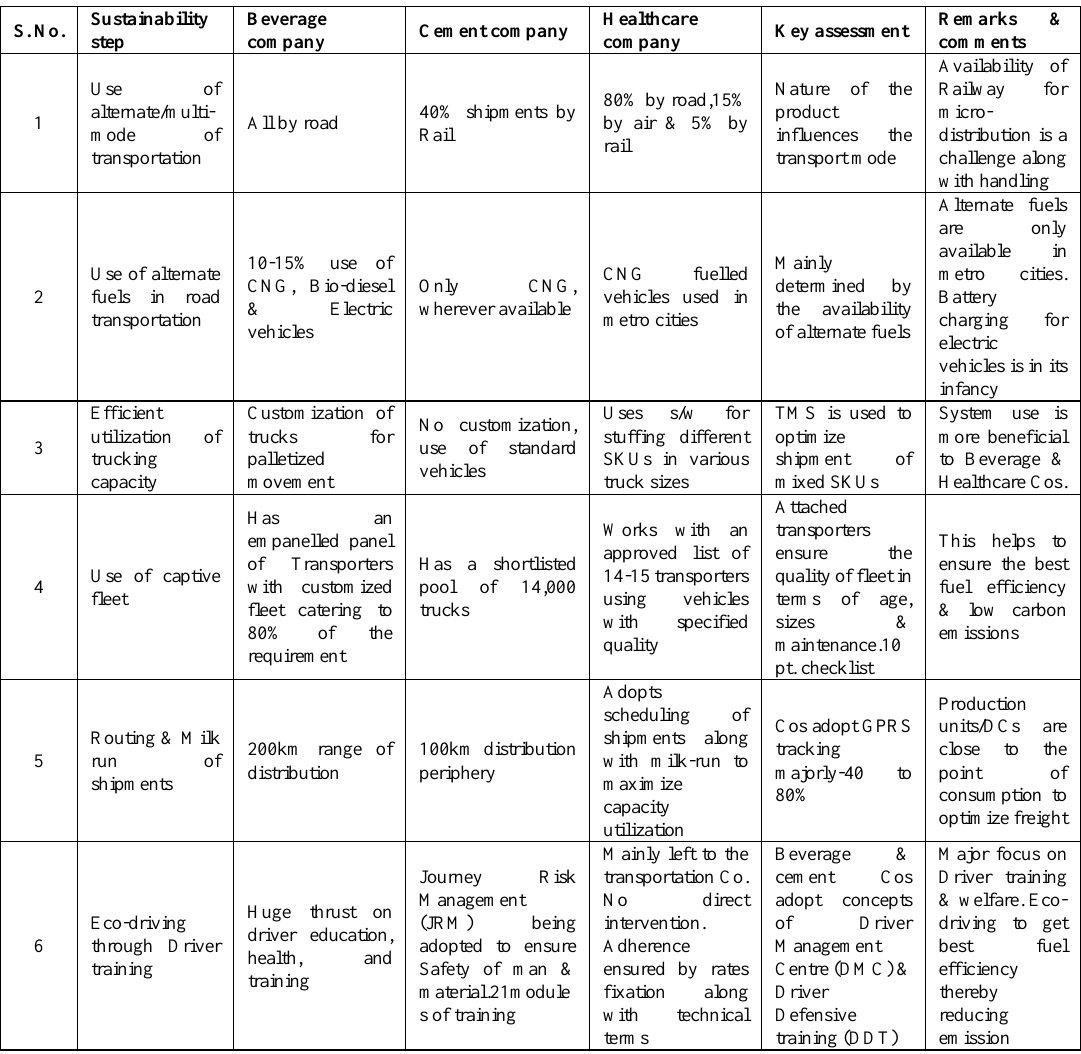
Table 3. Sustainability steps in the area of road